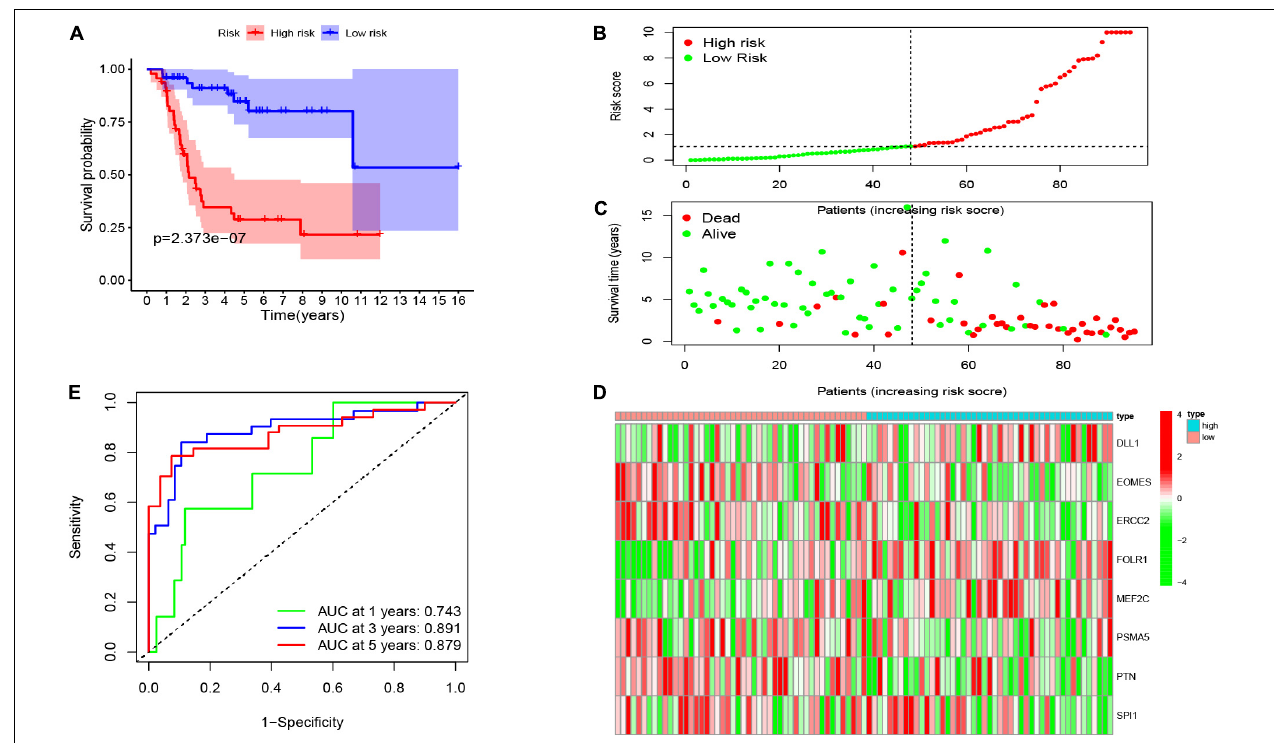
FIGURE 4 | (A) The Kaplan–Meier (K-M) curve of the eight-gene signature in the TARGET cohort. The risk score (B) , survival time and status (C) , as well as the expression of the eight genes (D) in the TARGET set. (E) The receiver-operating characteristic (ROC) curve and AUC value of the eight-gene signature in the TARGET